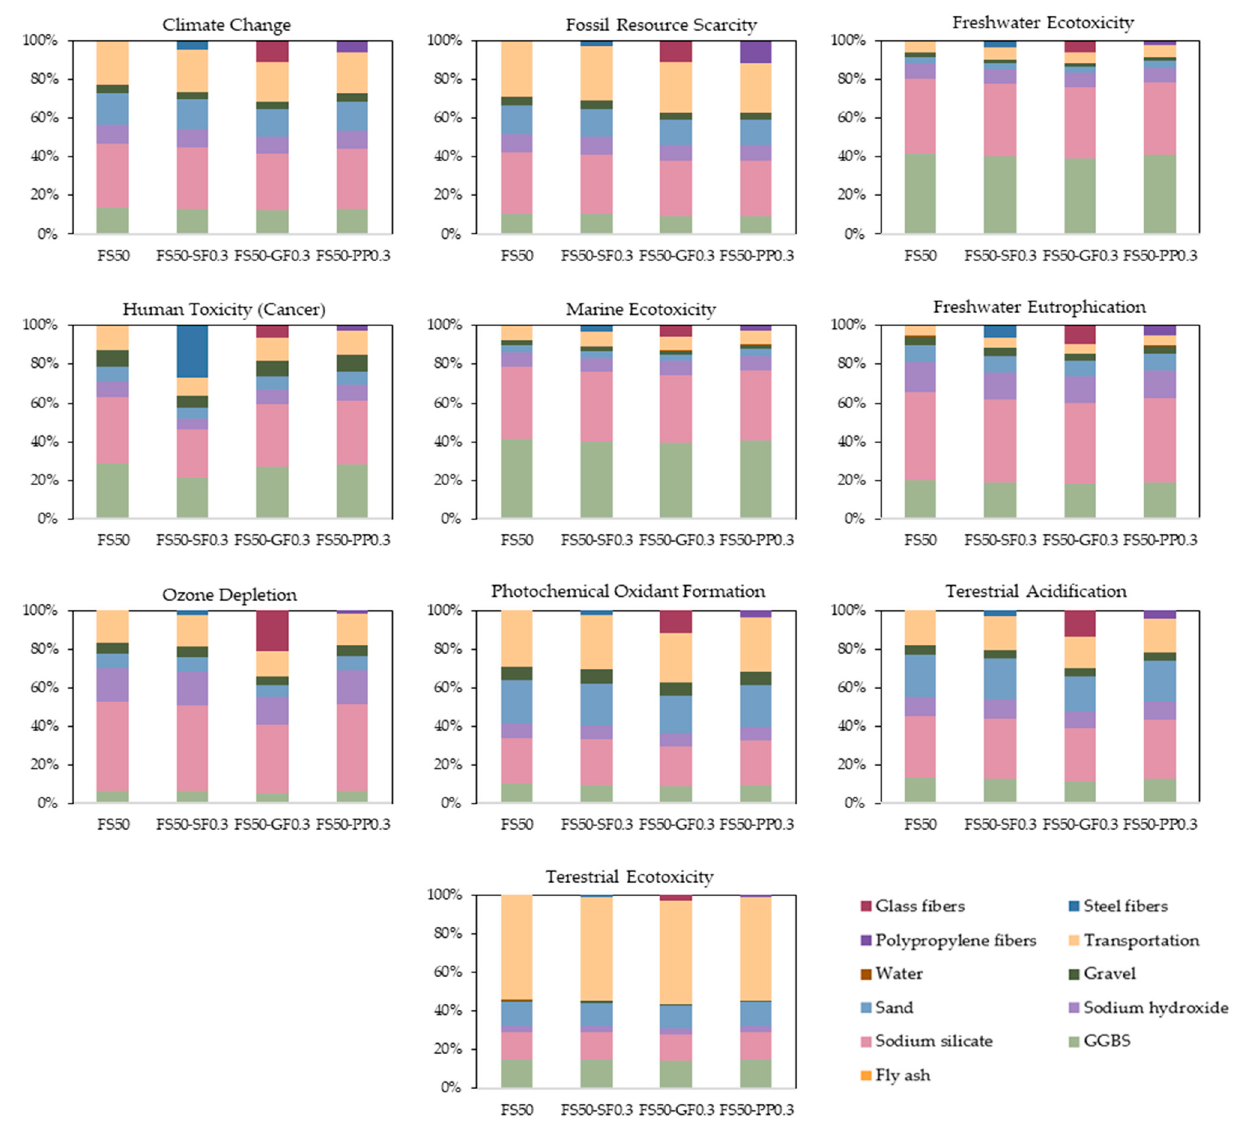
Figure 7. Process contribution (%) of FRAAC on midpoint impact categories.